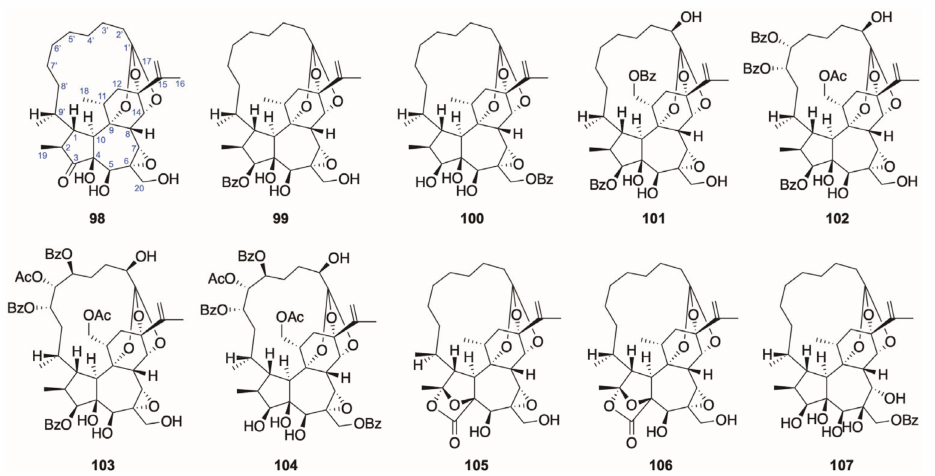
Figure 6. Structures of 1-alkyldaphnanes ( 98 – 107